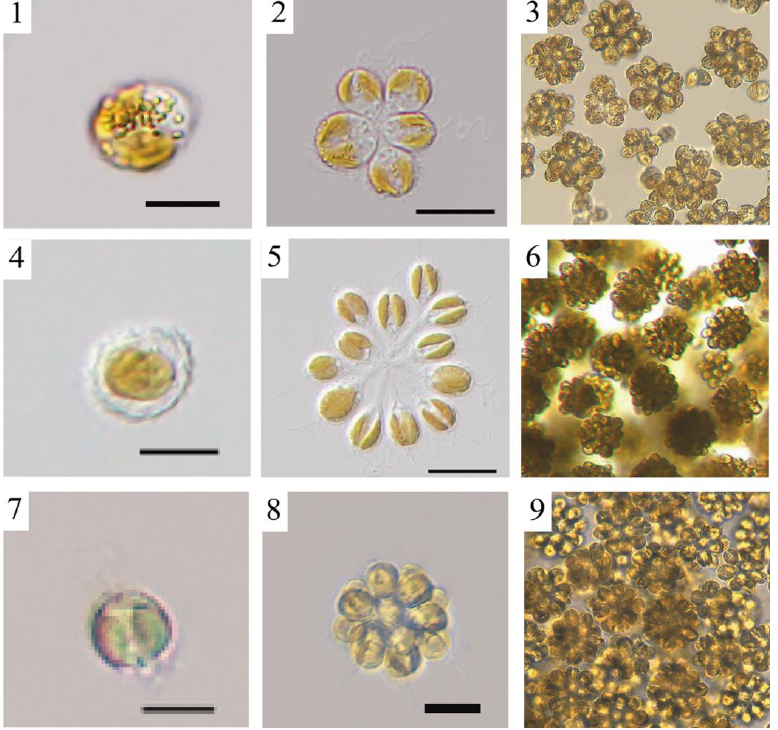
Figure 3. Light micrographs of Synura species. ( 1 ) A single cell of Synura longitubularis ; ( 2 ) Five-celled colony of S. longitubularis ; ( 3 ) Group of colony ( S. longitubularis culture); ( 4 ) A single cell of S. petersenii collected from Guizhou, China; ( 5 ) Twelve-celled colony of S. petersenii collected from Guizhou, China. Long colorless cytoplasmic stalks connecting individual cells are visible; ( 6 ) Group of colony (Culture of S. petersenii collected from Guizhou, China); ( 7 ) A single cell of S. glabra collected from Shanxi, China; ( 8 ) Colony of S. glabra collected from Shanxi, China. Compact colony formed by densely grouped cells; and ( 9 ) Group of colony (Culture of S. glabra collected from Shanxi, China). Scale bars: ( 2, 5, 8 ) = 20 μ m, ( 1, 4, 7 ) = 10 μ m.